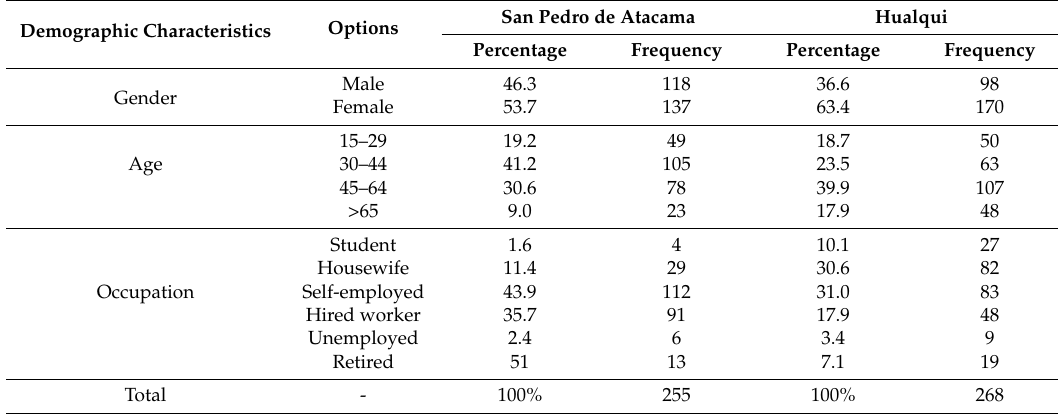
Table 2. Characteristics of the surveyed group of San Pedro de Atacama and Hualqui.